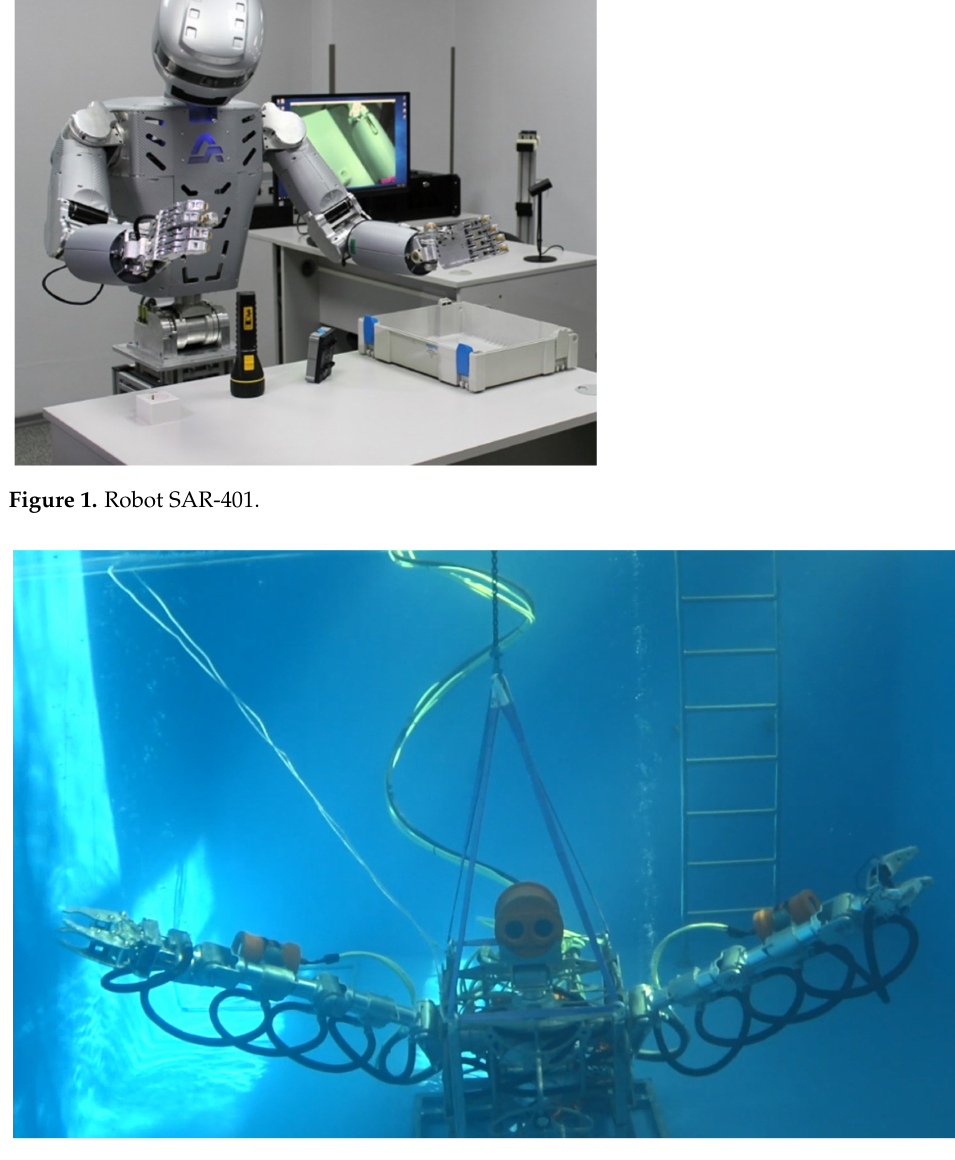
Figure 2. The underwater robot